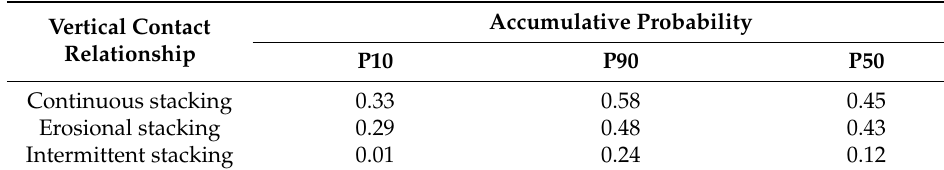
Table 6. Probability statistics of vertical contact relationships of architectural elements.